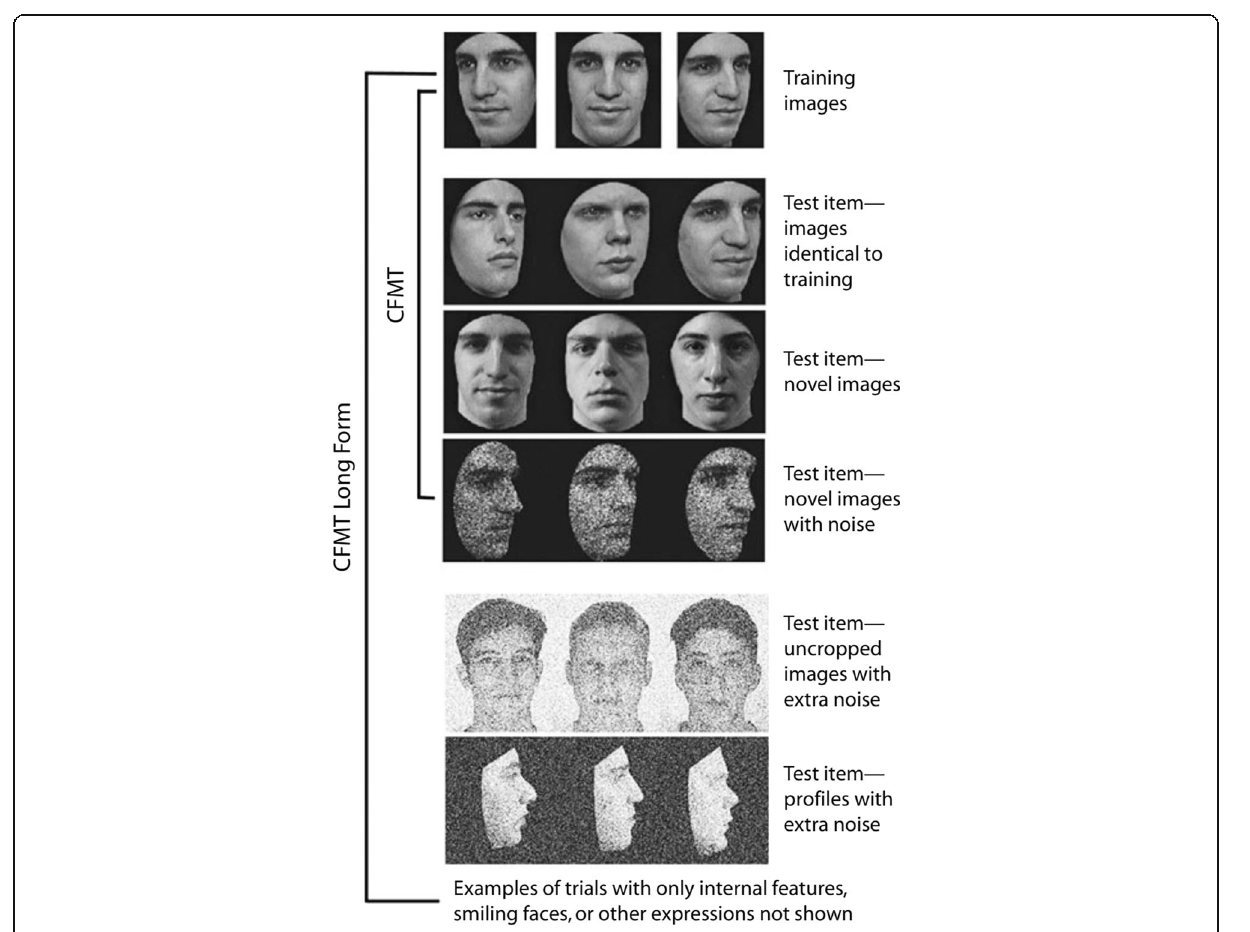
Fig. 3 Example stimuli and the structure of the long-form Cambridge Face Memory Test (CFMT+; from Russell et al.,